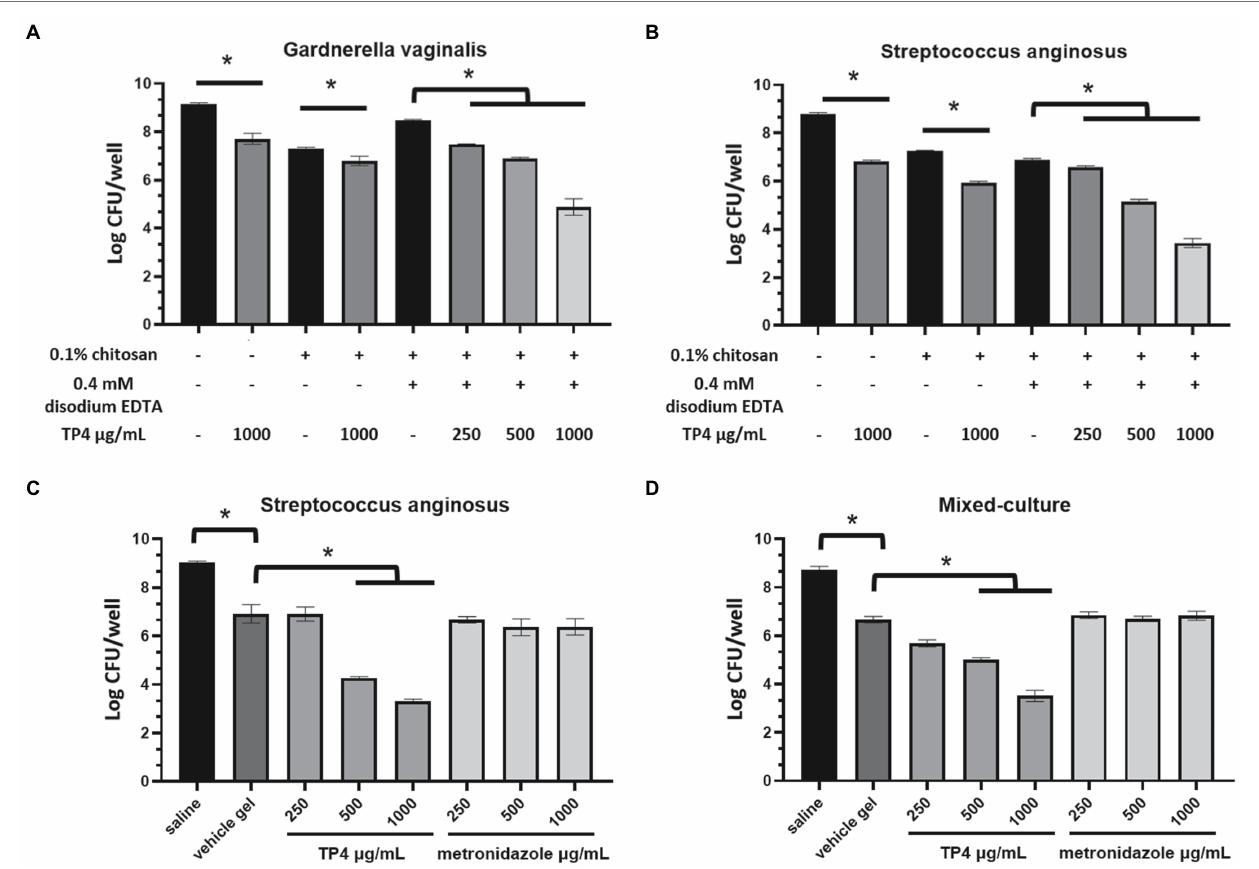
FIGURE 2 | Tilapia piscidin 4 and disodium EDTA formulated in chitosan reduces bacterial viability in BV-associated bacteria biofilms. Mature biofilms formed by BV-associated bacteria Gardnerella vaginalis (A) or Streptococcus anginosus (B) were treated with different combinations of TP4, disodium EDTA and chitosan. Mature biofilms formed by (C) S. anginosus or (D) S. anginosus combined with G. vaginalis (mixed culture) were treated with different concentrations of TP4 or metronidazole in vehicle gel (0.1% chitosan + 0.4 mM disodium EDTA). Biofilm cell viability was measured in terms of CFU counts. All values represent the mean ± SD of three individual experiments (* p < 0.05, one-way